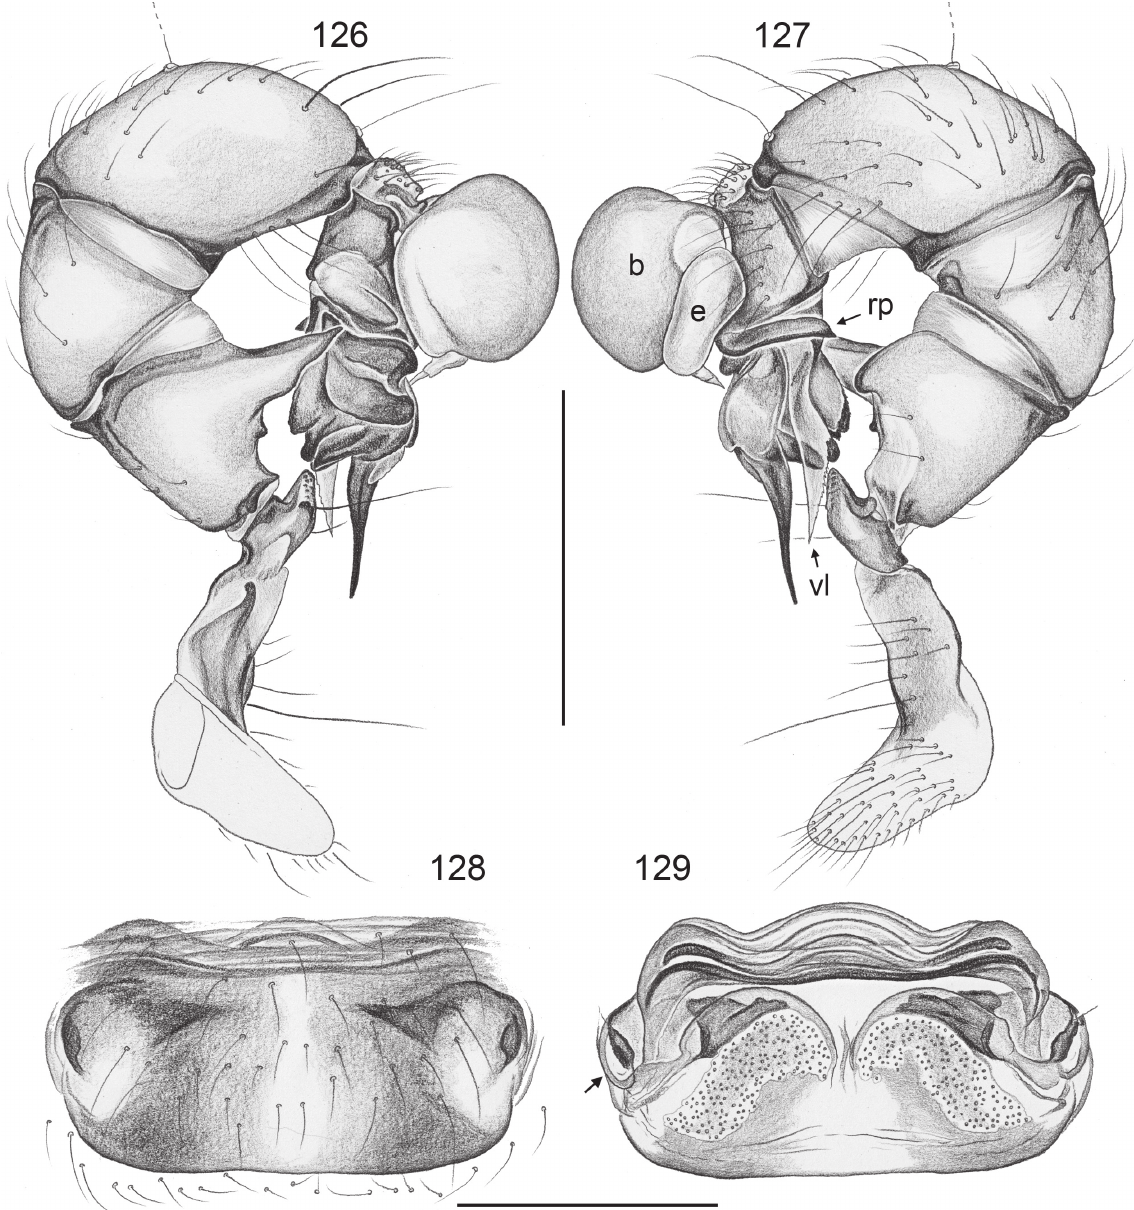
Figs 126–129. Aetana gaya Huber, sp. nov. 126–127 . Left male palp, prolateral and retrolateral views. 128–129 . Cleared female genitalia, ventral and dorsal views (arrow points at membranous pocket). b = genital bulb; e = embolus; rp = retrolatero-ventral process; vl = ventral lamina. Scale lines: 126–127 = 0.5 mm; 128–129 = 0.3